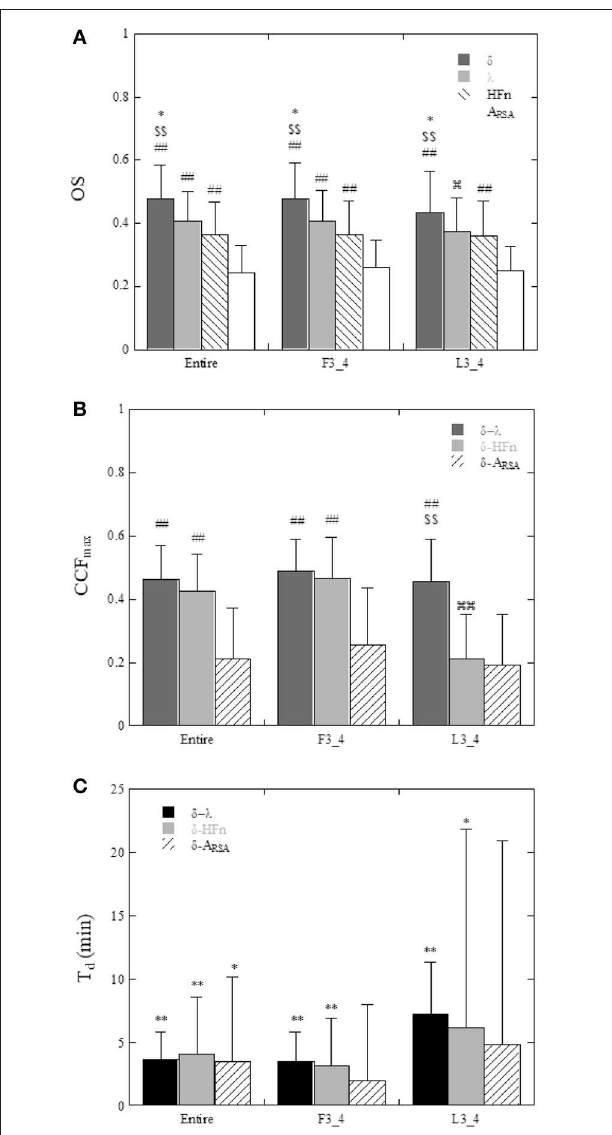
FIGURE 6 | (A) Comparison of the oscillation strength (OS) of the ACF of δ -wave, λ , HF n , and A RSA calculated for the entire night (Entire), the first three quarters (F3_4), and last three quarters (L3_4) of the sleep period. * P < 0.05 vs. λ , $$ P < 0.01 vs. HF n , ## P < 0.01 vs. A RSA , P < 0.05 vs. Entire and F3_4. (B) Maximum values of the cross-correlation function (CCF max ) between δ -wave and λ , between δ -wave and HF n , and between δ -wave and A RSA . ## P < 0.01 vs. δ -A $$ P < 0.01 vs. δ -HF n , P < 0.01 vs. Entire and RSA , F3_4. (C) Time delay (T d ) of the δ -wave from the changes in λ , HF n , and A RSA . Statistical comparison of T d was performed with the null hypothesis of a zero time delay for each variable. * P < 0.05, ** P < 0.01.